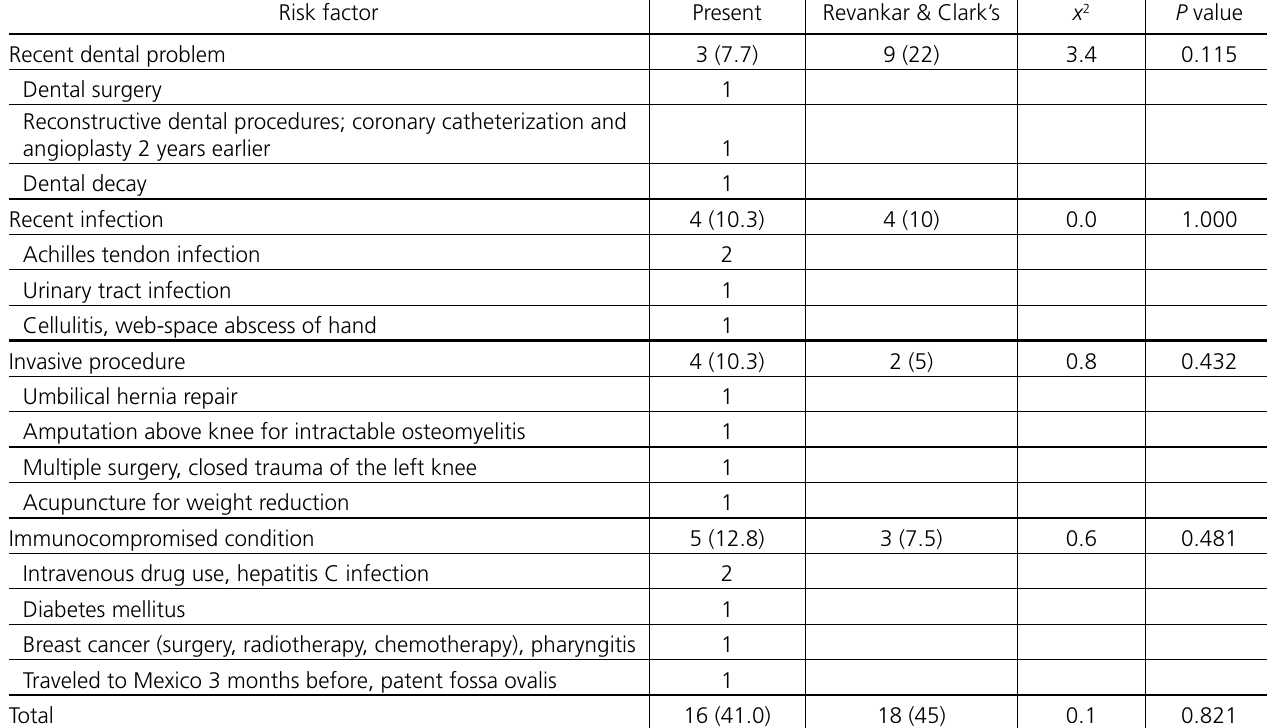
The onset symptoms and signs of the 37 patients (2 patients’ symptoms were not reported) with infected cardiac myxoma were listed in Table 3. Fever was the most common symptom accounting for 97.3% of all cases. The fever nature